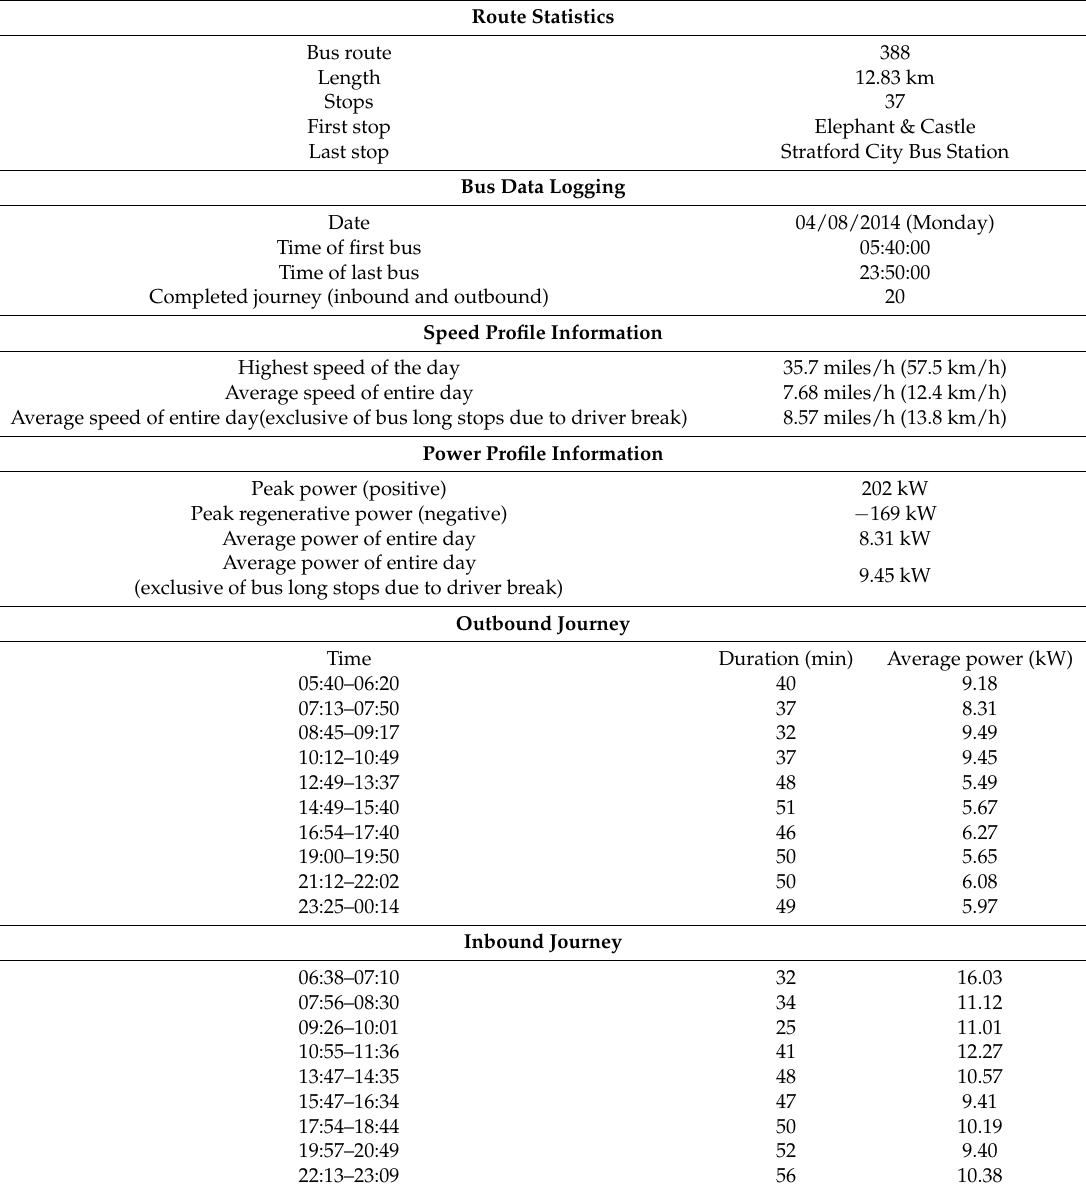
Table 1. Route 388 bus data logging